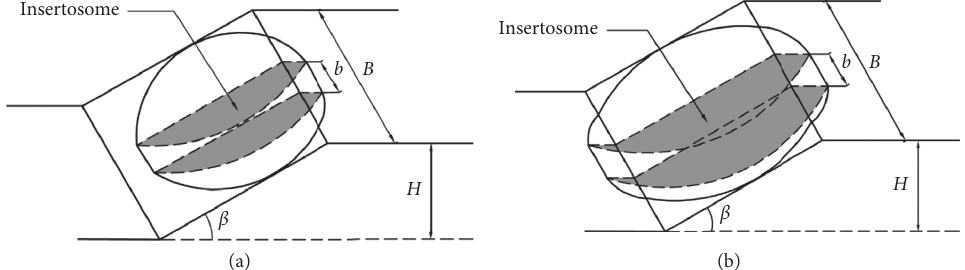
Figure 3: Oblique view of modified 3D failure mechanisms [3]. (a) Face-failure mechanism. (b) Base-failure